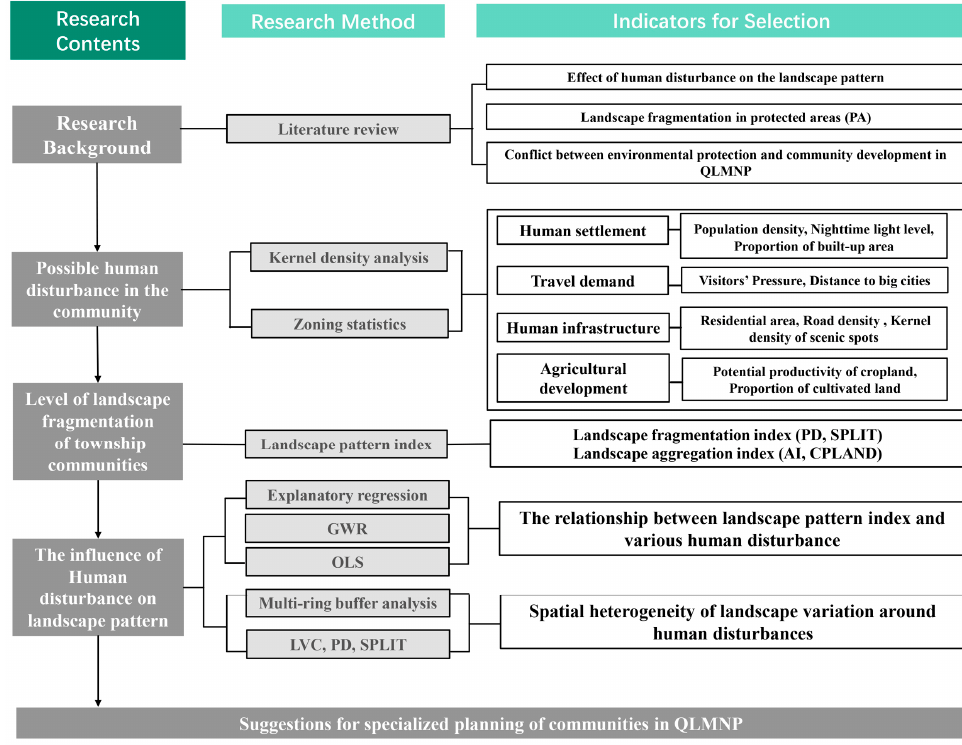
Figure 3. The research workflow.